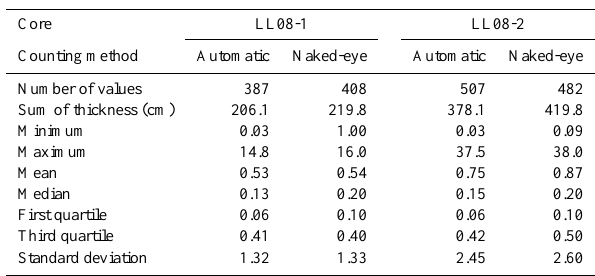
Table 2. Descriptive statistics of flood deposits from both cores and